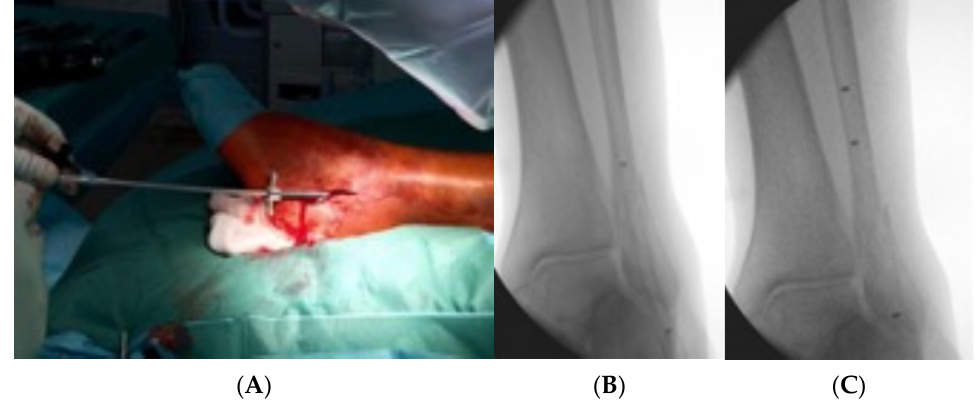
Figure 4. This figure demonstrates the insertion of the implant into the fibula via the already placed sheath ( A ), the fluoroscopic control of the insertion ( B ) and confirmation of the final position via fluoroscopic control and radiopaque markers on the implant ( C ).